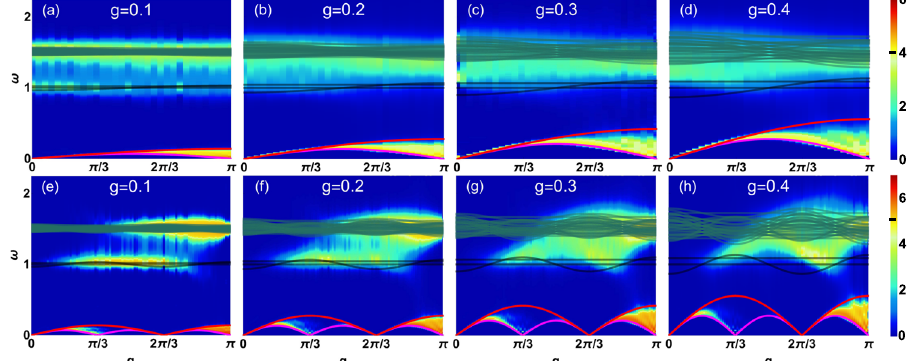
Fig. 4 QMC-SAC results compared with perturbative energy levels. a – d Show results for S red ( q , ω ) in the reduced BZ, while e − h show S ( q , ω ) in the full BZ as in Fig. 2. In a – d the magenta and red solid lines are respectively the lower boundary ω l ¼ π J eff sin ð q Þj j = 2 and upper boundary π J = 2 Þj j of the two-spinon continuum, the black solid lines represent the dispersion relations (see Eqs. 6 − 8) corresponding to the ω u ¼ eff sin ð q intermediate-energy spectrum. The green solid lines are the dispersion relations (see Eqs. 9 − 17) corresponding to the higher-energy spectrum. The dispersion relations in full BZ are obtained by unfolding the results in the reduced BZ. The boundaries between the linear and logarithmic color mappings are a – d U 0 = 4 and e – h U 0 = 5, respectively, as indicated on the color